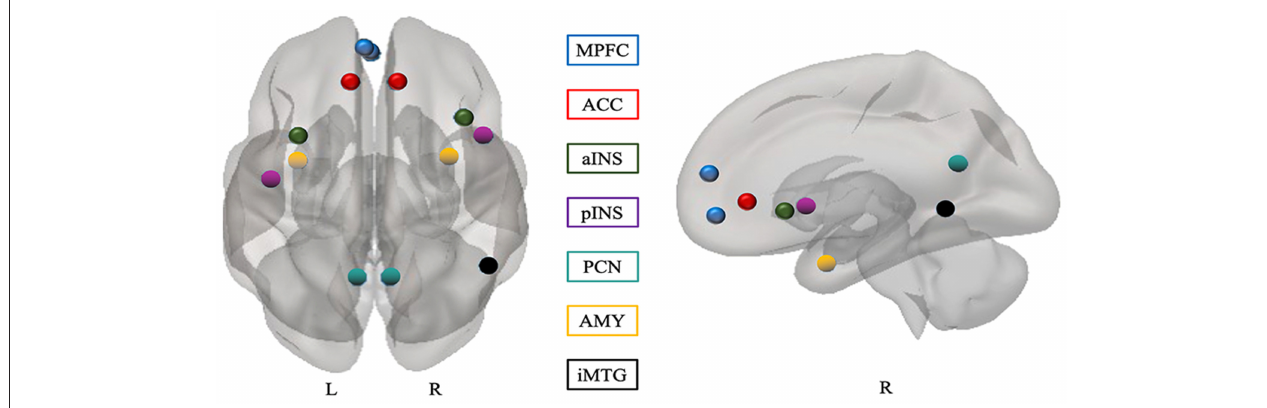
FIGURE 1 | Seeds for functional connectivity. All seeds were defined based on previous studies (see Table S1 in the Supplementary Materials). MPFC, medial prefrontal cortex; ACC, anterior cingulate cortex; PCN, precuneus; iMTG, inferior middle temporal gyrus; AMY, amygdala; INS, insular cortex; L, left; R, right; a, anterior; p, posterior.